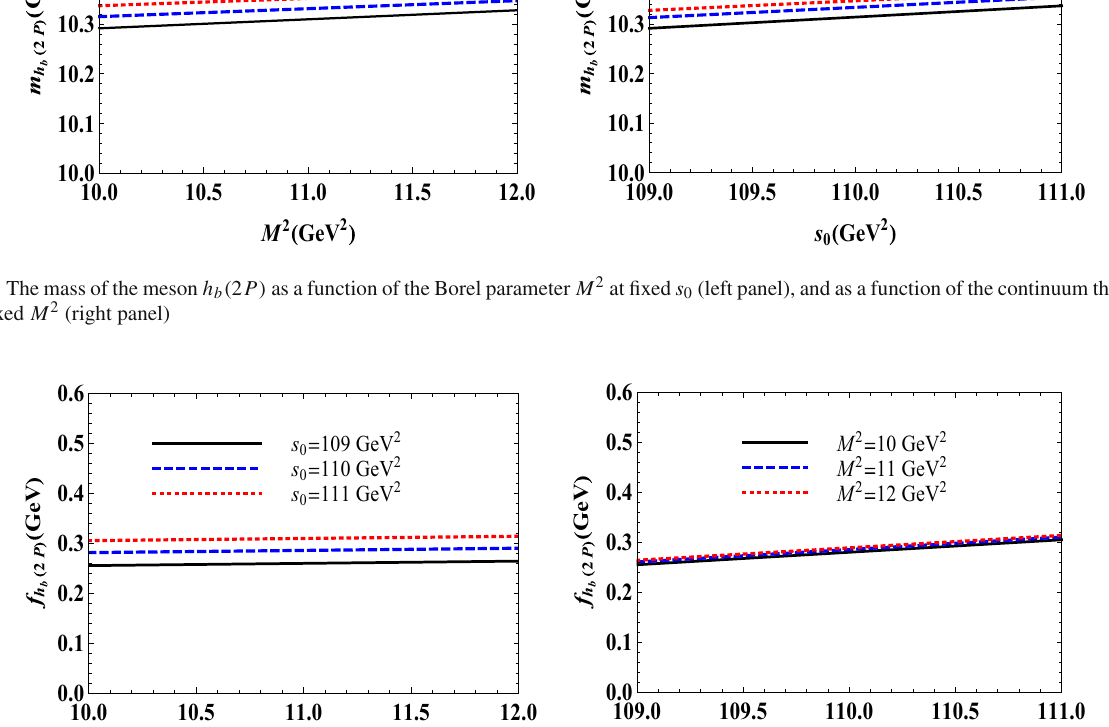
on the Borel parameter at chosen values of s 0 (left panel), and on s 0 at fixed M 2 (right b ( 2 P )